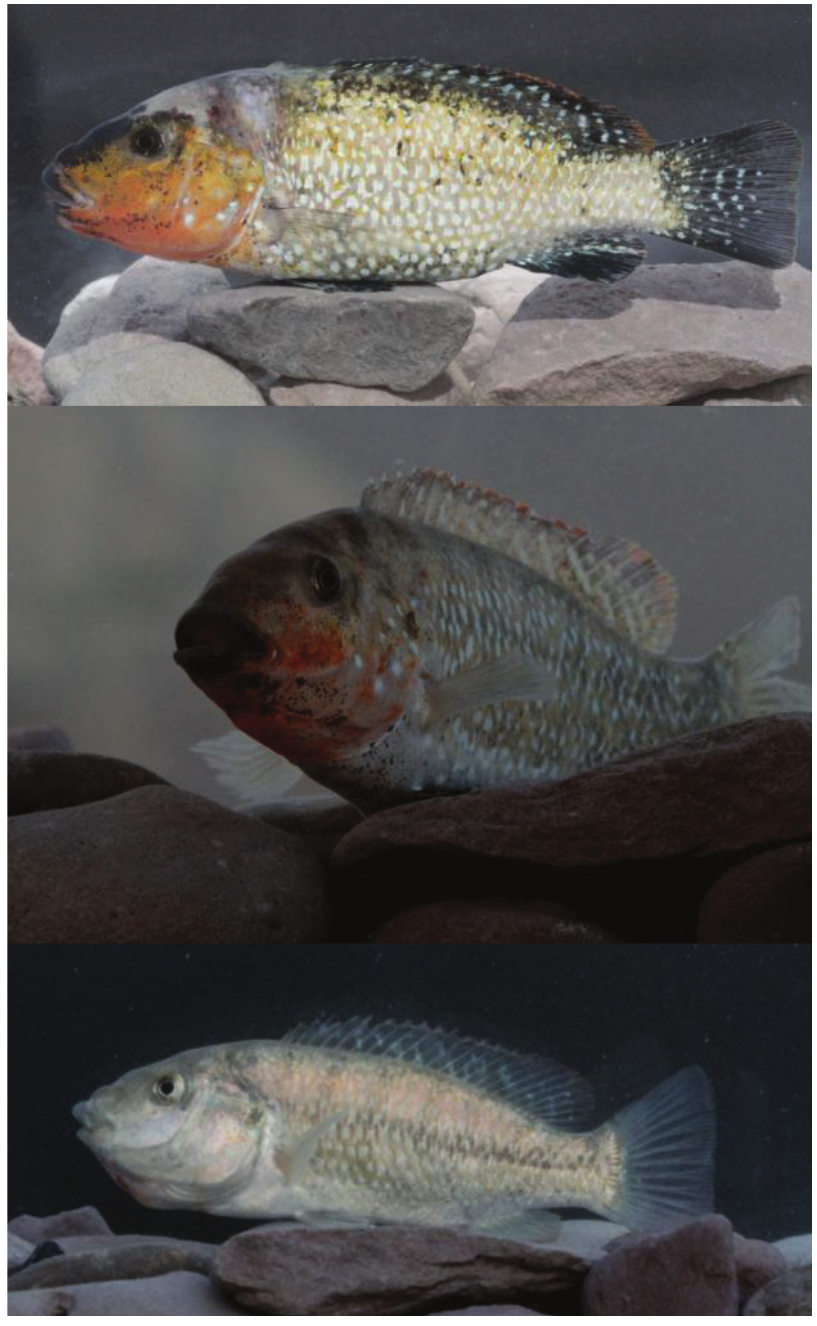
Figure 5. Iranocichla persa , ZM-CBSU-IP64, male, paratype, 86.7 mm SL; Hormuzgan prov.: Shur River, ZM-CBSU-IP67, male, paratype, 75.8 mm SL; Hormuzgan prov.: Khorgo Hot spring, ZM-CB- SU-IP73, female with eggs in her mouth, paratype, 76 mm SL; Hormuzgan prov.: Khorgo Hot